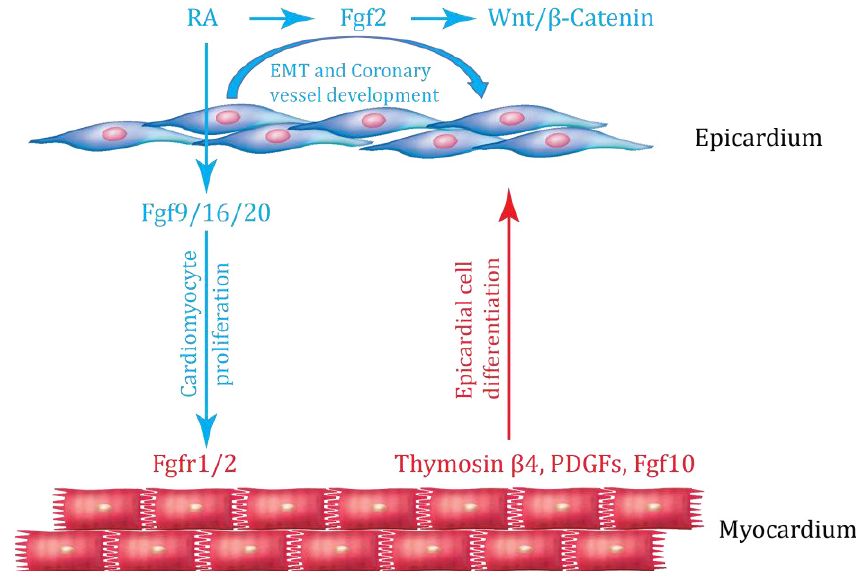
Figure 3. Reciprocal interactions between epicardium and myocardium during cardiac development. Retinoic acid (RA) modulates epicardial EMT and coronary vascular development by regulating Fgf2 and Wnt/ (cid:533) -catenin signaling. RA also activates Fgf9 expression in the epicardium, which signals via receptors Fgfr1/2 to regulate myocardial proliferation and differentiation. Signals from the myocardium, such as Thymosin (cid:533) 4, platelet-derived growth factors (PDGFs) and fibroblast growth factors (FGFs), regulate epicardial cell differentiation.